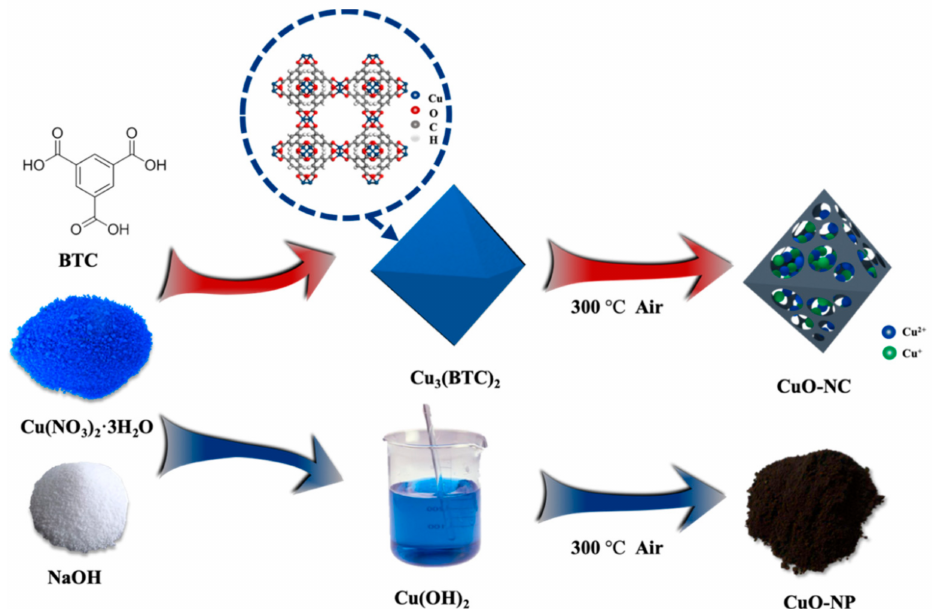
Figure 8. Schematic of the synthesis process of nano −